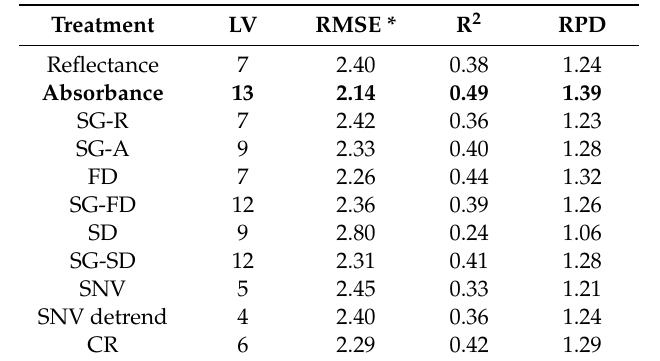
Table A1. Descriptive statistics of the SOC calibration dataset and the results of the Partial Least Squares Regression (PLSR) model per various spectral pre-treatments. R = Reflectance, A = Absorbance, SG = Savitzky–Golay smoothing, FD = 1st derivative, SD = 2nd derivative, SNV = standard normal variate, CR = continuum removal. In bold is the pre-treatment which provides the best model.